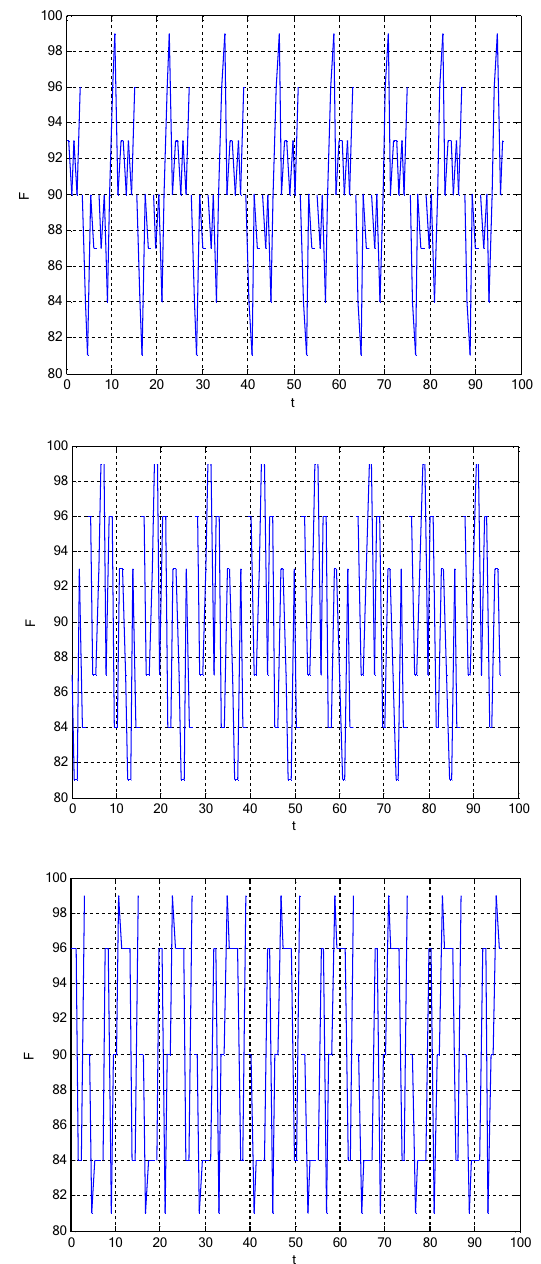
Fig. 9 Additional loads on the platform due to pumping unit under random conditions